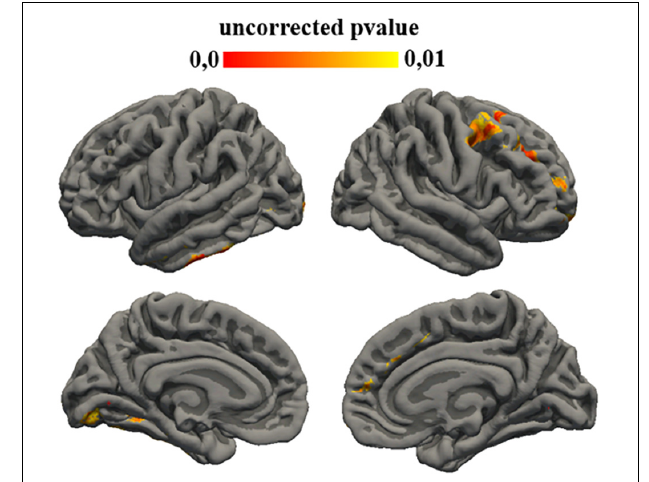
FIGURE 2 | Uncorrected p -value maps for gyrification ADI-communication correlation. Significance was set at 0.01.